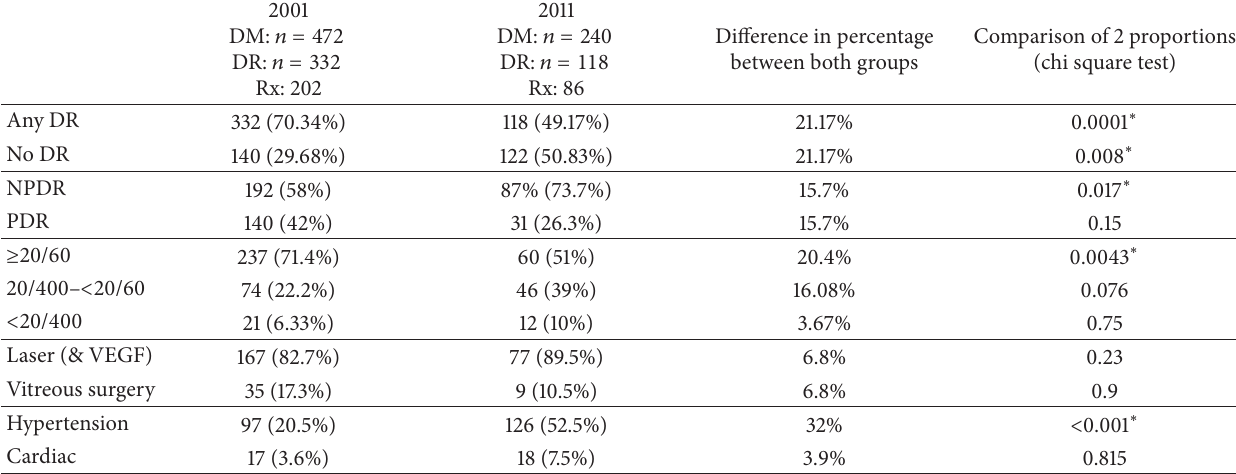
Table 1: Comparison of clinical presentation in years 2001 and